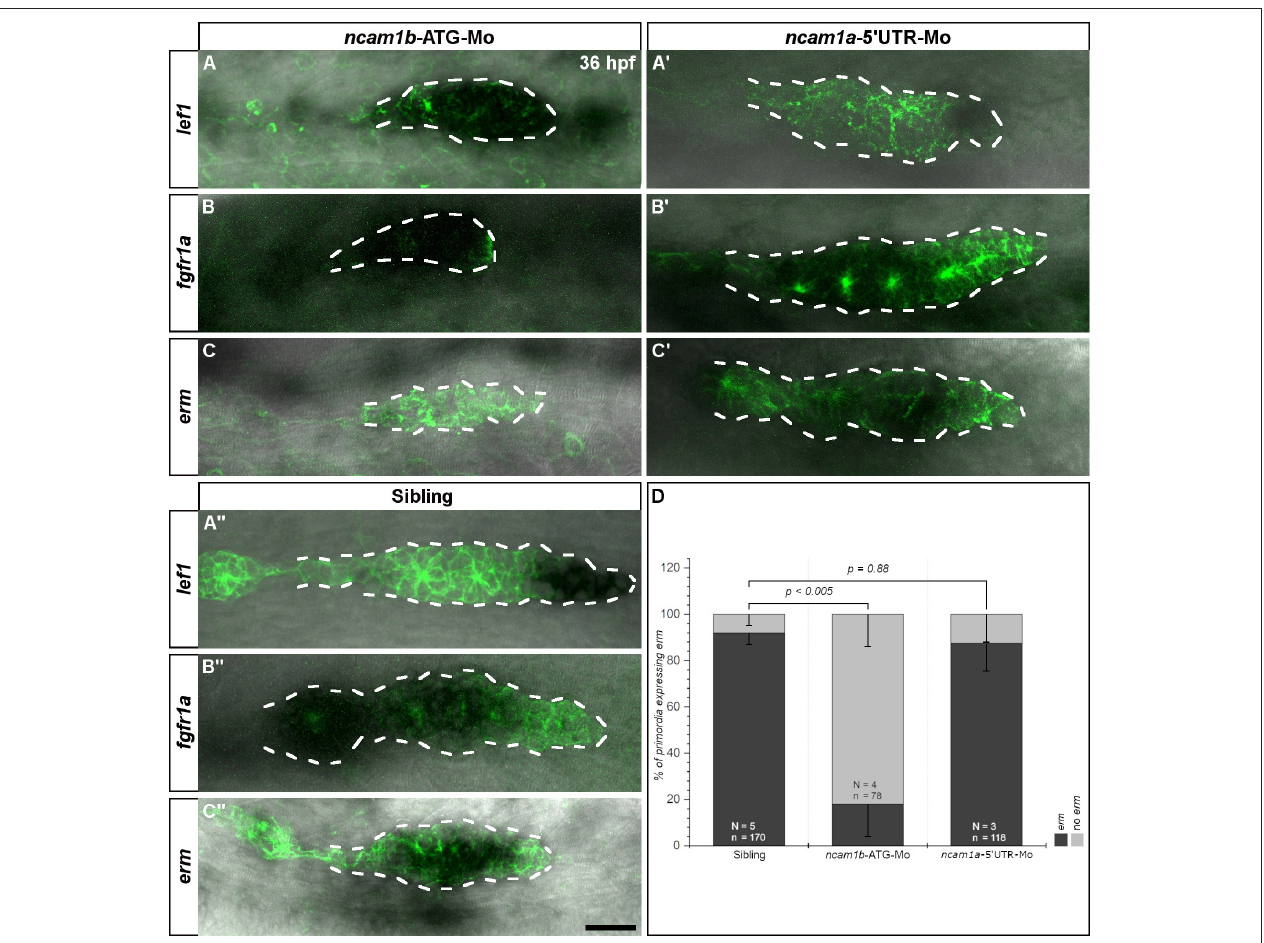
FIGURE 3 | Ncam1b affects the expression of the Fgfr1a-target gene erm . Tg(ClaudinB::lynGFP) embryos were immunostained labeled for GFP (green). In situ hybridizations of probes detecting lef1 (Leading-Zone), fgfr1a, or erm (both in the Trailing-Zone) were visualized by NBT/BCIP staining. Primordia outlines are surrounded with a dotted line for better visibility. (A–C) Neither expression of lef1 nor of fgfr1a are affected in ncam1b -morphants, whereas erm expression is markedly reduced. ( A ′ ,C ′ ) Neither ncam1a -morphants nor ( A ′′ ,C ′′ ) siblings show alterations for lef1 , fgfr1a, or erm . (D) Reduced erm expression after knockdown of ncam1b . Error bars show standard deviation. X 2 -test with ns = p ≥ 0.05. Scale bar 20 µ